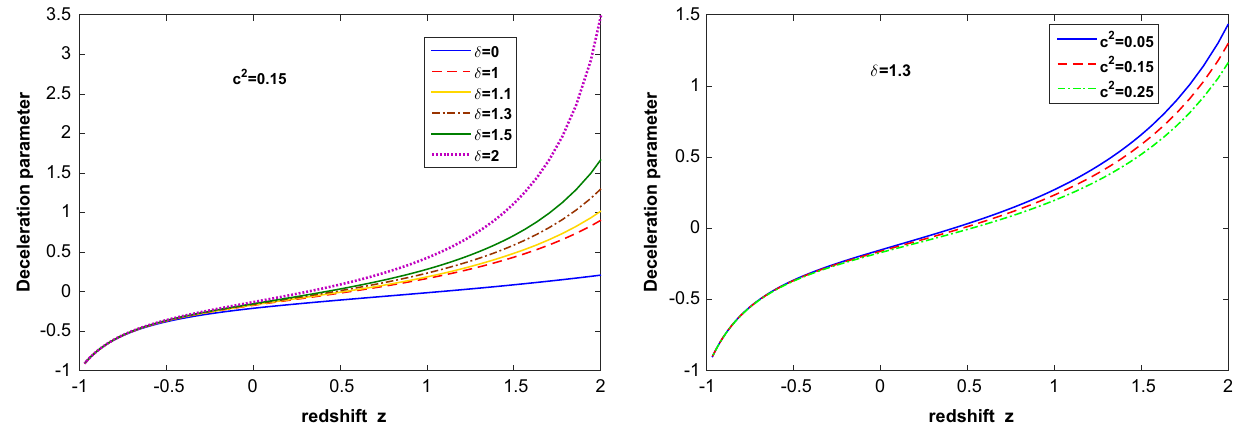
= 0 . 73, u = 0 . 3 and δ = 1 . 3 de